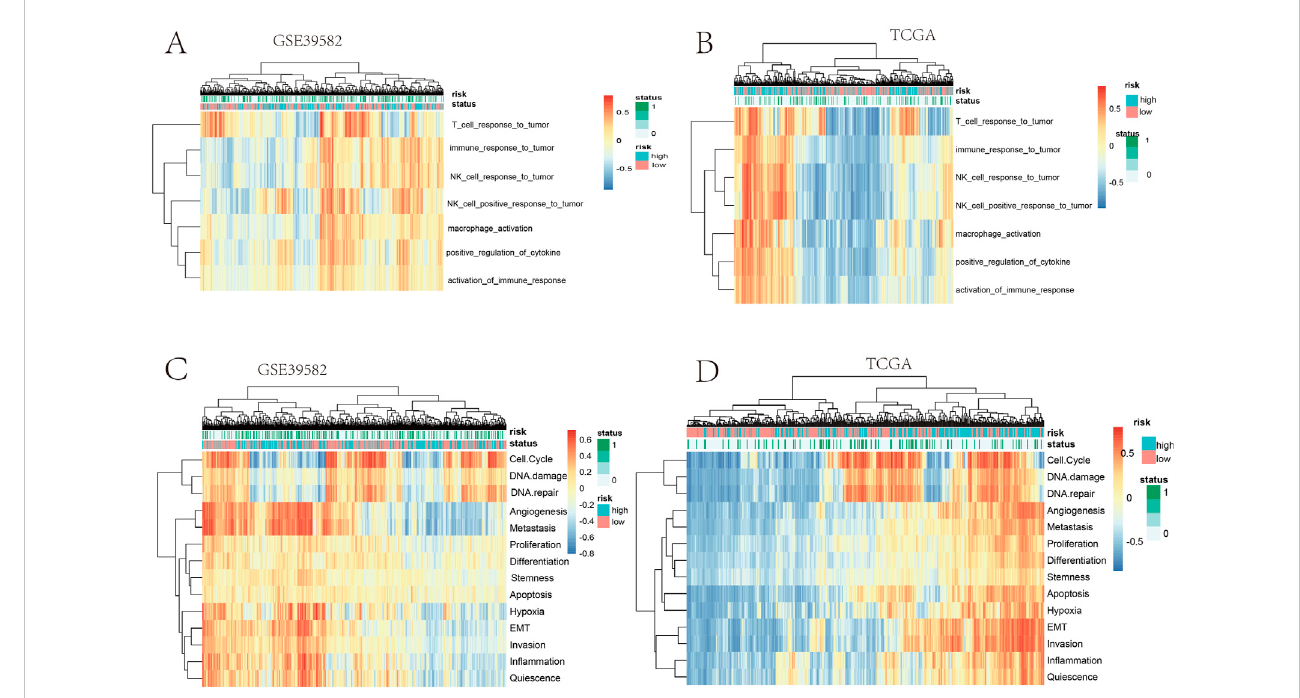
FIGURE 2 (A,B) Heatmap clustering oftheriskscore andimmunesignatures inthetraining cohort. (C,D) Heatmap clustering of theriskscore and tumor signatures in the validation